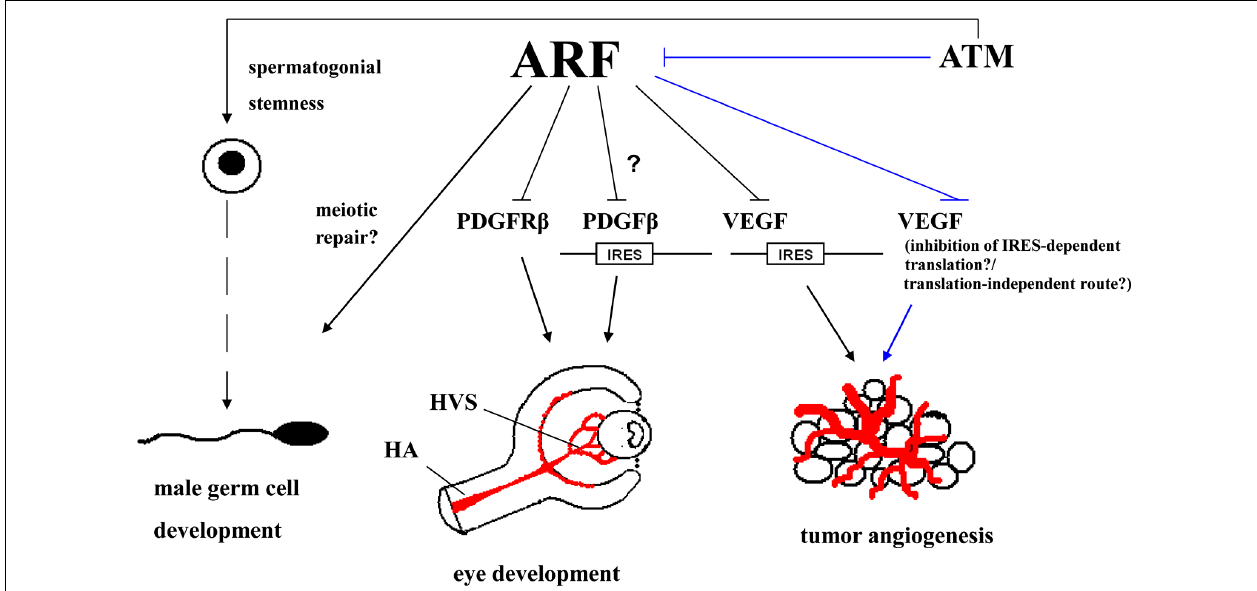
FIGURE 2 | ARF impinges both on developmental processes (male germ cell development and ocular development in mice) and tumor angiogenesis. ARF is essential for normal spermatogenesis in mice possibly through interacting with the meiotic repair machinery. In the ocular development of the mouse, ARF is required for the involution of the hyaloid vascular system (HVS); a transient network of vessels that provides nutrients to the developing oculus. This is accomplished via a pathway in which ARF blocks platelet-derived growth factor receptor β (PDGFR β )-dependent signaling which in turn, is necessary for the investment of vessels by mural cells and their maintenance. This may also be possibly regulated via the ARF-dependent inhibition of internal ribosome entry site (IRES)-mediated translation of PDGFR β . ARF can also suppress the